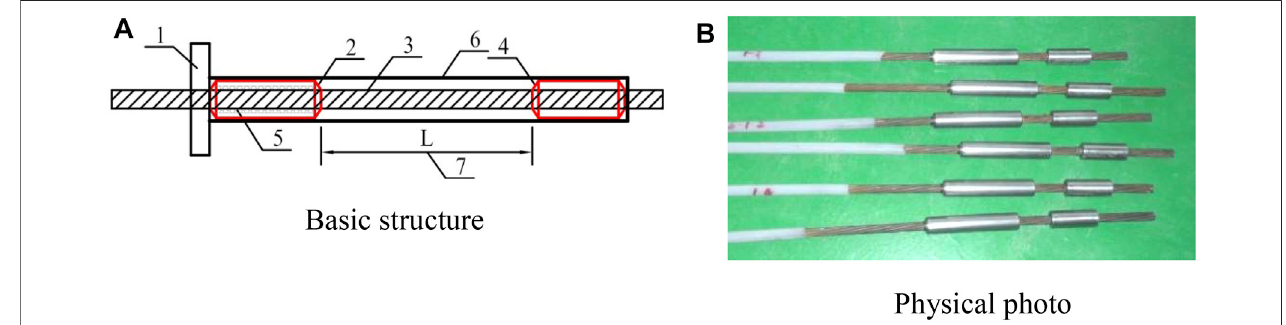
FIGURE 1 | Basic structure and photograph of an anti-seismic anchor cable. 1-bearing plate; 2-anti-seismic anchor (sliding extrusion sleeve); 3-unbonded steel strand; 4-permanent anchor ( fi xed extrusion sleeve); 5-frictional material fi ll; 6- seal cover; 7-preset slipping distance. (A) Basic structure. (B) Physical photo.